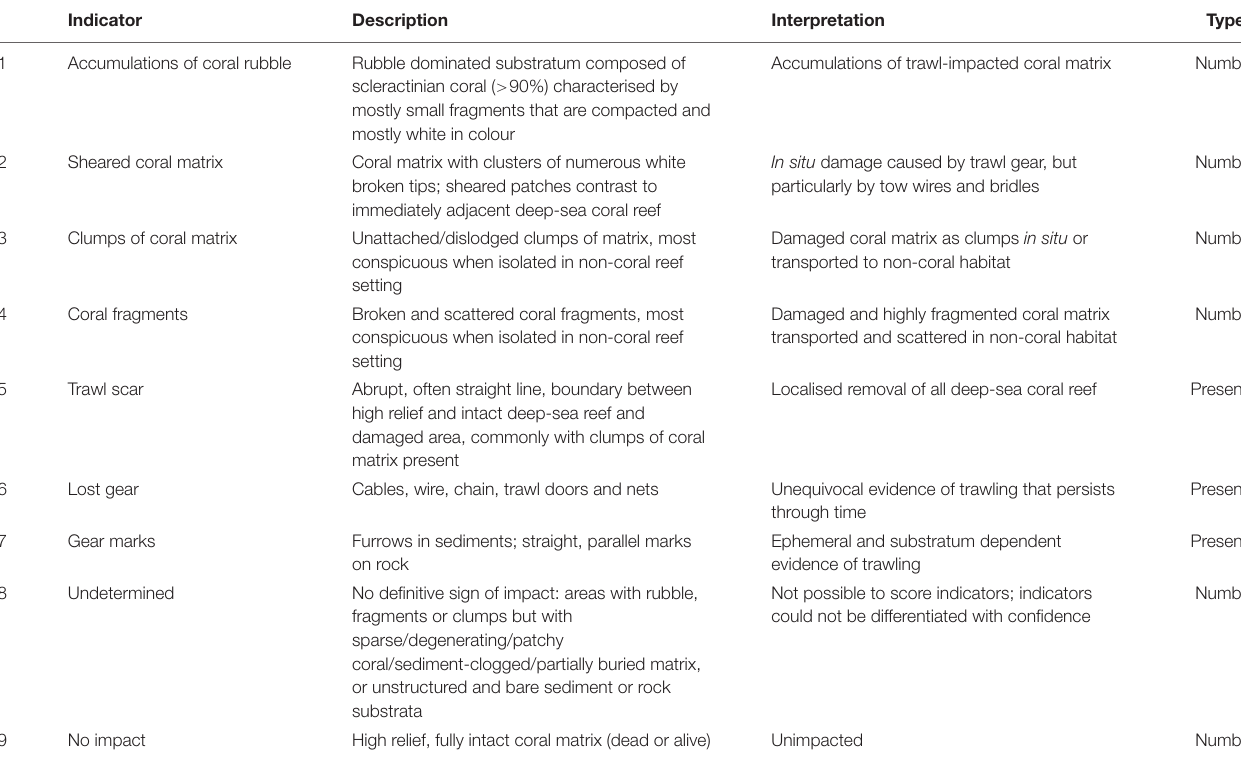
TABLE 2 | Indicators used to assess the level of trawl impact and lack of impact on scleractinian deep-sea coral reef, showing their description and interpretation, and the type of data derived from either video (presence only) or still imagery (counts). Indicator Description Interpretation